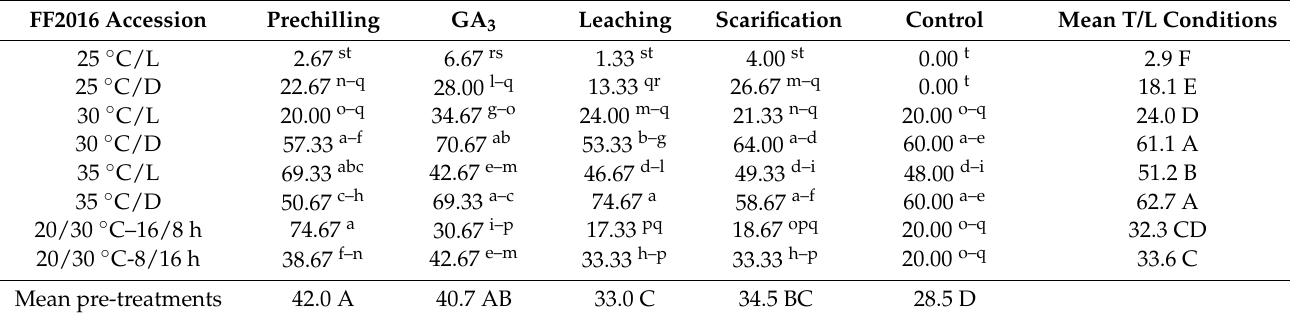
Table 4. Effect of the pre-germination treatments (A), temperature/light conditions (B), and their reciprocal interactions (A × B) on germination percentage of P. incarnata FF2016 accession.